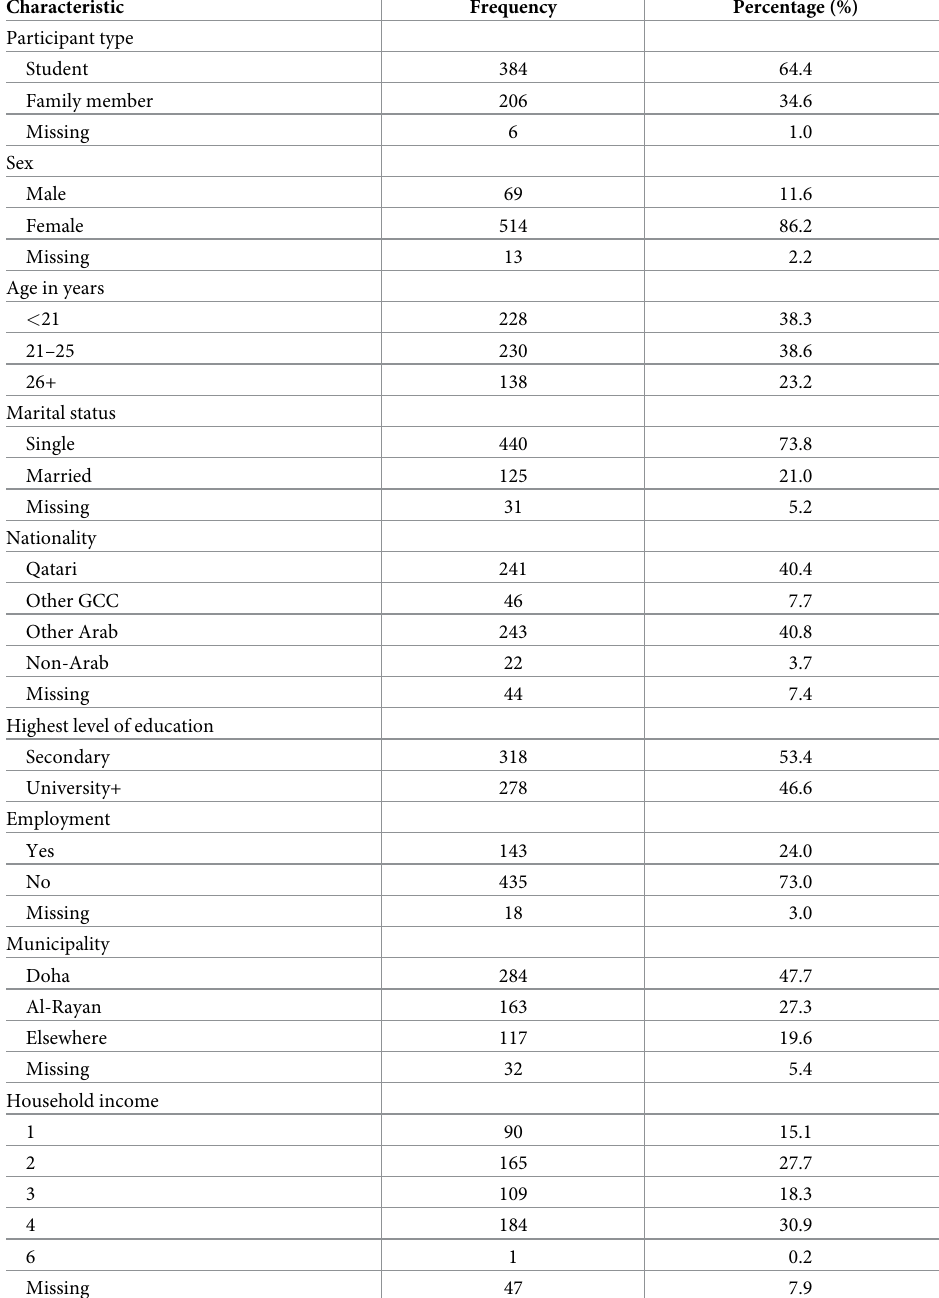
Table 1. Sociodemographic characteristics of respondents (n =